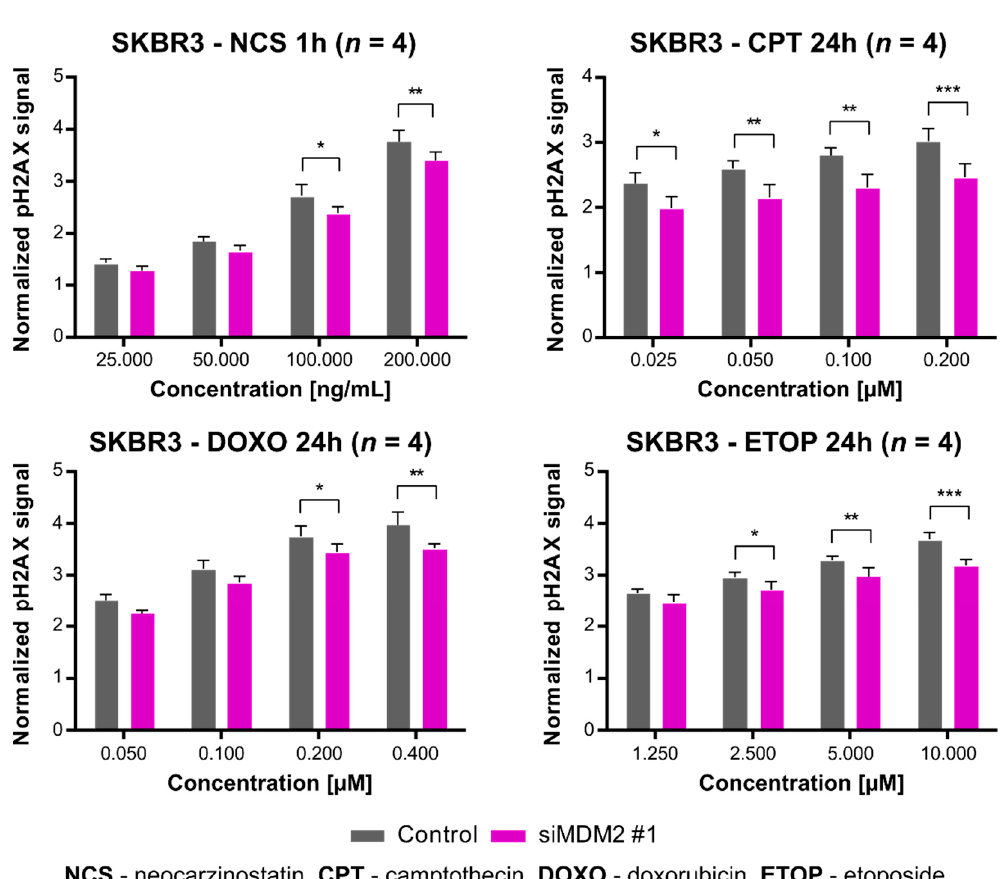
Figure 3. In-cell western analysis of histone H2AX phosphorylation after treatment with DNA-damaging agents and silencing of MDM2 gene expression in the SKBR3 cells. The signal from H2AX phosphorylation was normalized to untreated cells. Statistical significance was assessed by comparing siMDM2 with the control (non-specific siRNA) for all tested concentrations of compounds, * p < 0.05, ** p < 0.01, *** p < 0.001. Four independent biological experiments were performed for each chemotherapeutic ( n = 4).